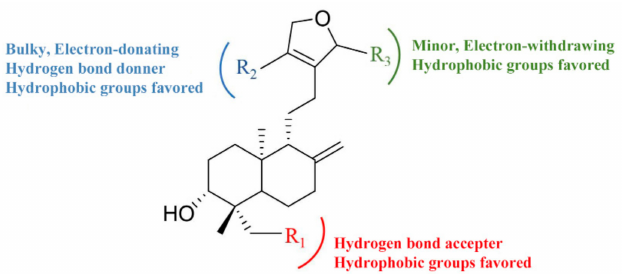
Figure 9. The structure-activity relationship of diterpenoid lactones revealed by 3D-QSAR study. 2.4. New Diterpenoid Lactones Inhibit the Activation of NF-Kb in LPS-Induced RAW 264.7 Cells